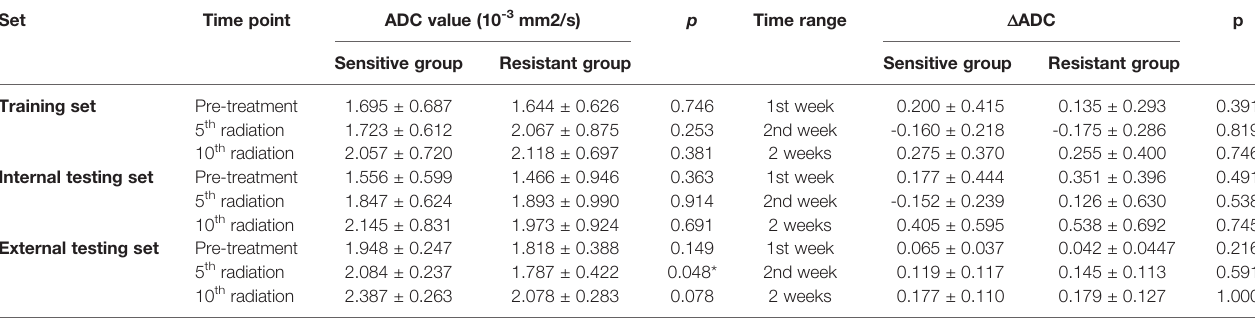
Resistant group